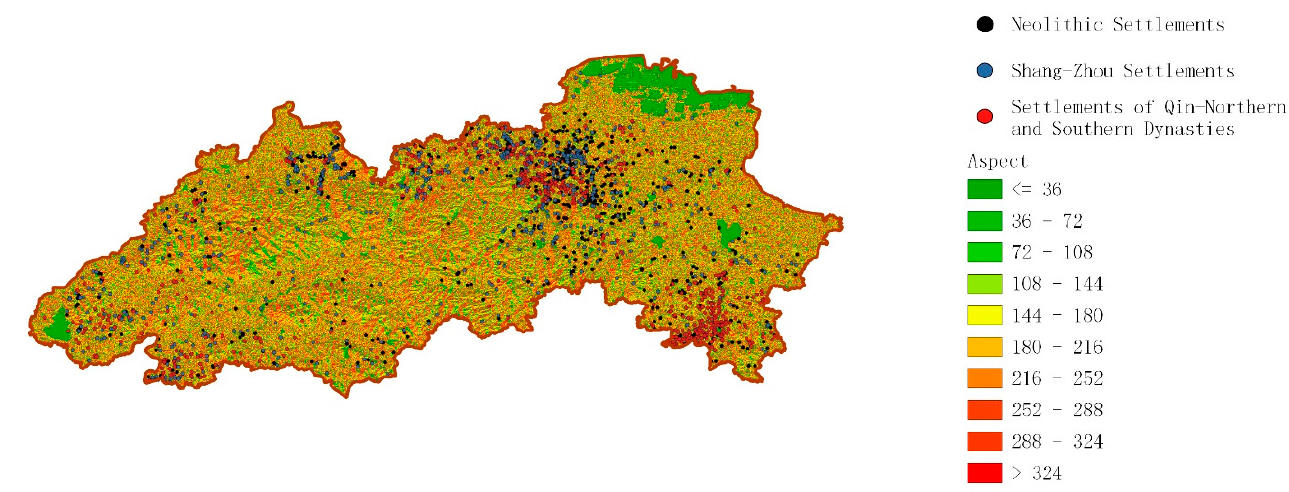
Figure 7. Aspect distribution of settlements in different periods.